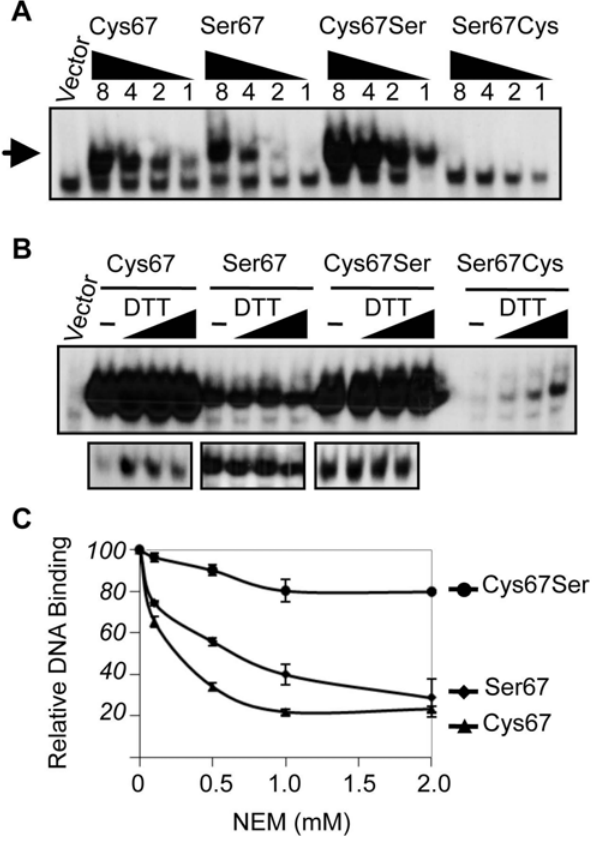
Figure 7. Effect of mutations at residue 67 on the DNA-binding activity of the two Nv-NF- k B proteins. (A) An EMSA was performed using a radioactive k B-site probe and A293 cell extracts containing equal amounts of each indicated FLAG-Nv-NF- k B protein (as deter- mined by anti-FLAG Western blotting). As in Figure 6A, two-fold dilutions of the equalized extracts were used in the EMSA. The position of the NF- k B-DNA complex is indicated by the arrow. Probe, probe alone. (B) An EMSA was performed using extracts from A293 cells as in (A), except that the extracts were supplemented with increasing concentrations (0, 1, 5, 25 mM) of dithiothreitol (DTT) for 18 h prior to adding the radioactive probe to the samples. The lower panels show lighter exposures of the top panel, so that the relative intensities of DNA binding at the different concentrations of DTT can be visualized. (C) An EMSA was performed using extracts from A293 cells transfected with plasmids for expression of the indicated Nv-NF- k B proteins. However, the extracts were incubated with the indicated concentra- tions of N-ethylmaleimide (NEM) for 30 min prior to adding the radioactive k B-site probe. Values for each protein designate the relative the amount of DNA-binding activity at a given concentration of NEM as compared to the activity in the absence of NEM. Values (with standard error) are the averages of three separate experiments.